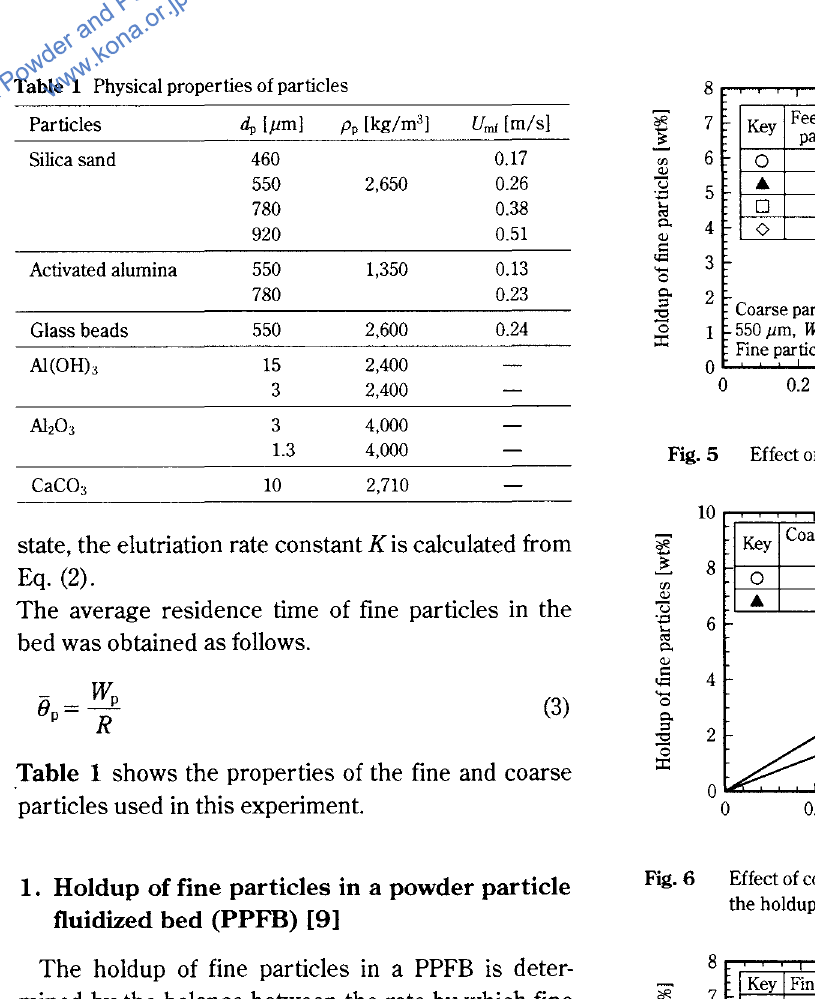
Fig. 6 Effect of coarse particle size and fine particle feed rate on the holdup of fine particles